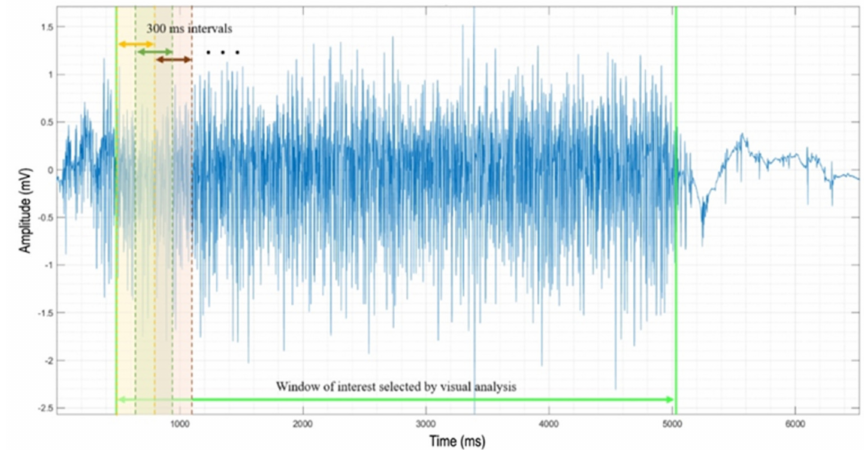
Figure 1. Exemplificative interference pattern analysis from BB muscle: the signal window between the two green vertical lines is selected by visual analysis by an expert technician. IP area is then computed on each 300 ms window. The window with the highest IP area is selected for the